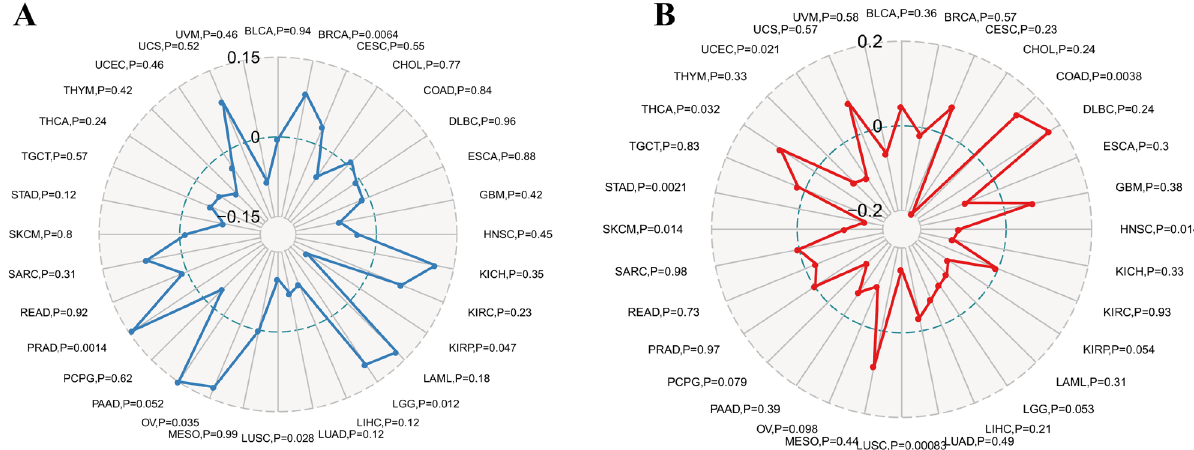
Figure 8. Correlation analysis of GSDMA expression with tumor mutational burden (TMB) ( A ) and microsatellite instability (MSI) ( B ) using Spearman’s rank correlation coefficient.